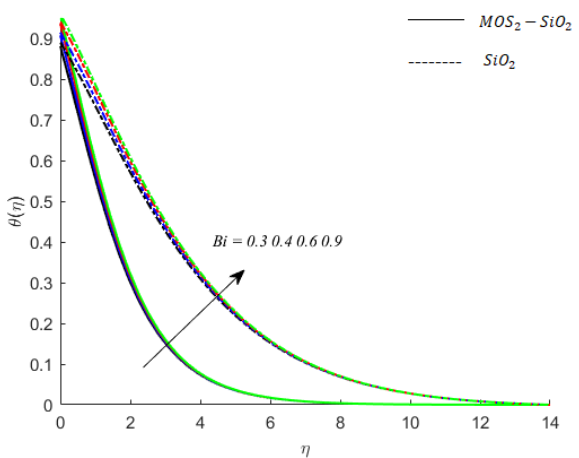
Figure 8. Influence of Bi on temperature when M = 0.9, Pr = 0.9, Ec = 0.2, Sc = 0.8,Ei = 0.1, K = 0.1, β ∗ = 0.1, γ = 0.1, γ 1 = 0.1.